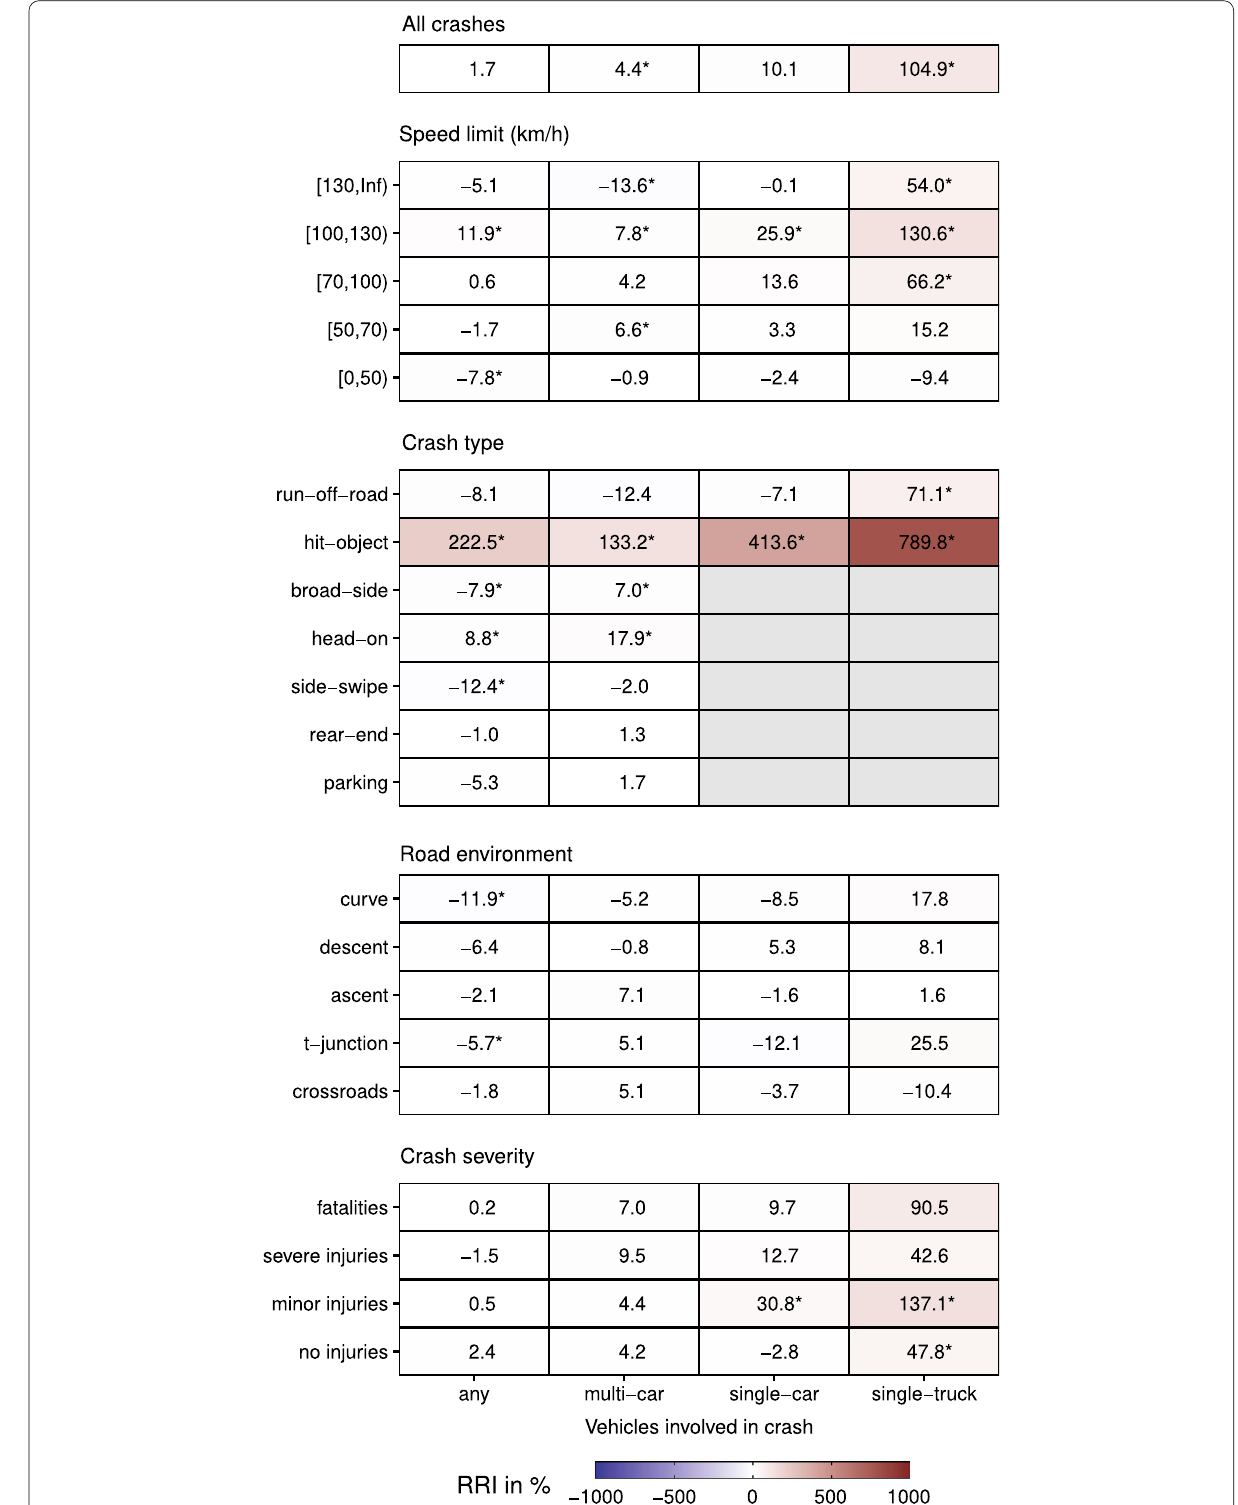
Fig. 6 Relative risk increase (RRI) of crash probabilities in situations with high wind speeds ( Wnd = 25 m/s) compared to situations with low wind speeds ( Wnd = 5 m/s) . Significant changes (i. e. more than 95 of 100 models fitted with randomly drawn training data show the same direction of change) are indicated with an